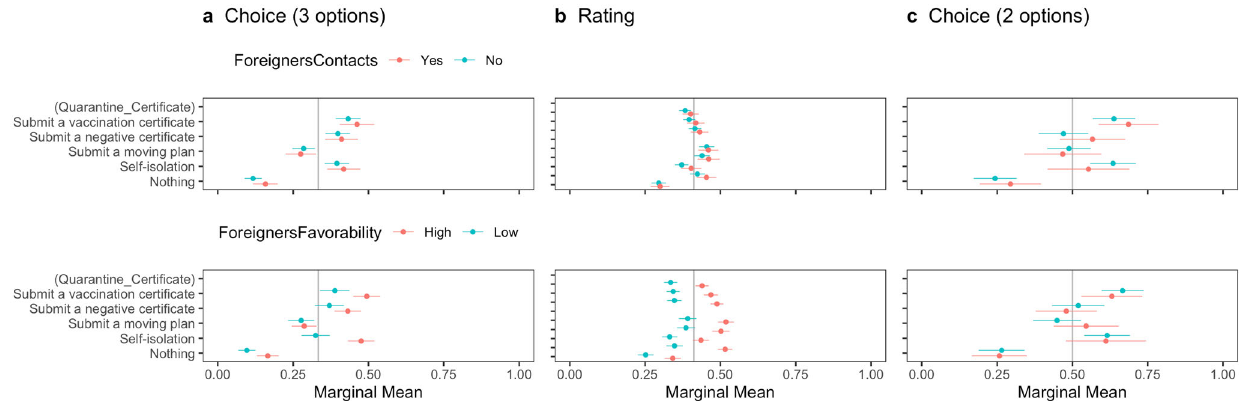
Fig. 5 Marginal means of the probability or rating for travelers ’ entry conditioned by associations with foreigners with error bars of 95% con fi dence intervals. The vertical lines show the random probability (0.33) for Panel a using the choice-based question (three options including “ Neither should be admitted ” ), the mean (0.41) for Panel b using the rating-based question, and the random probability (0.5) for Panel c using the choice-based question (two options).